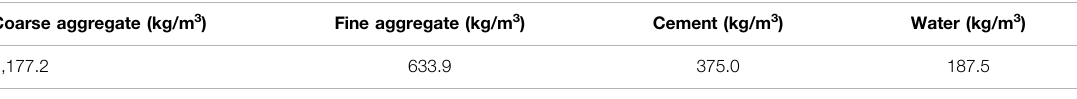
TABLE 2 | Mix composition of the substrate concrete.